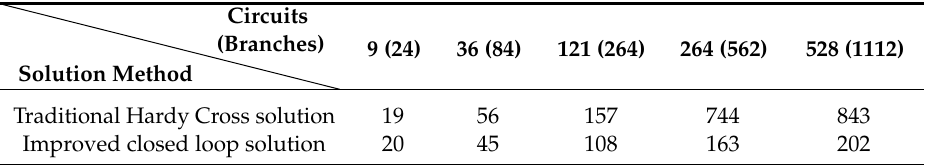
Table 2. Comparison of the iterative number for ventilation networks with di ff erent branches using the traditional Hardy Cross solution method with the improved closed loop solution method.